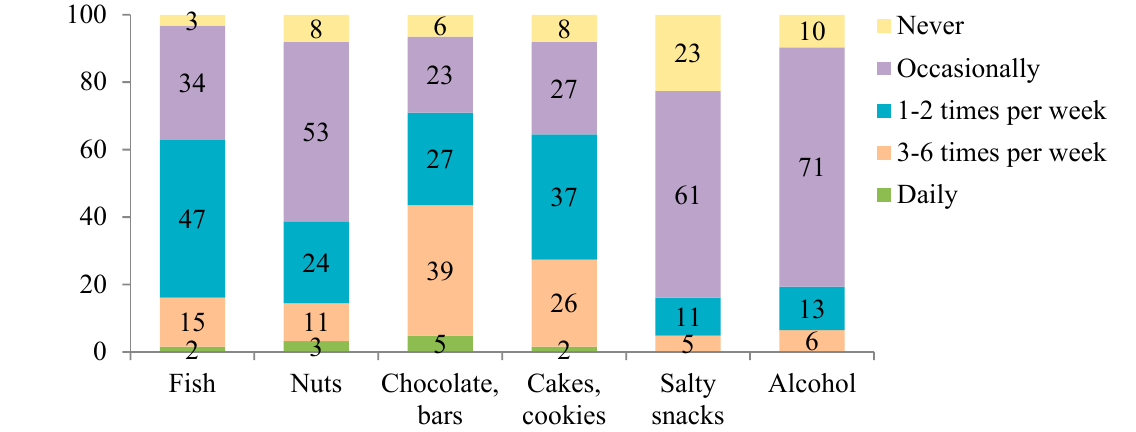
Figure 2. The least often consumed food groups ( n = 62).